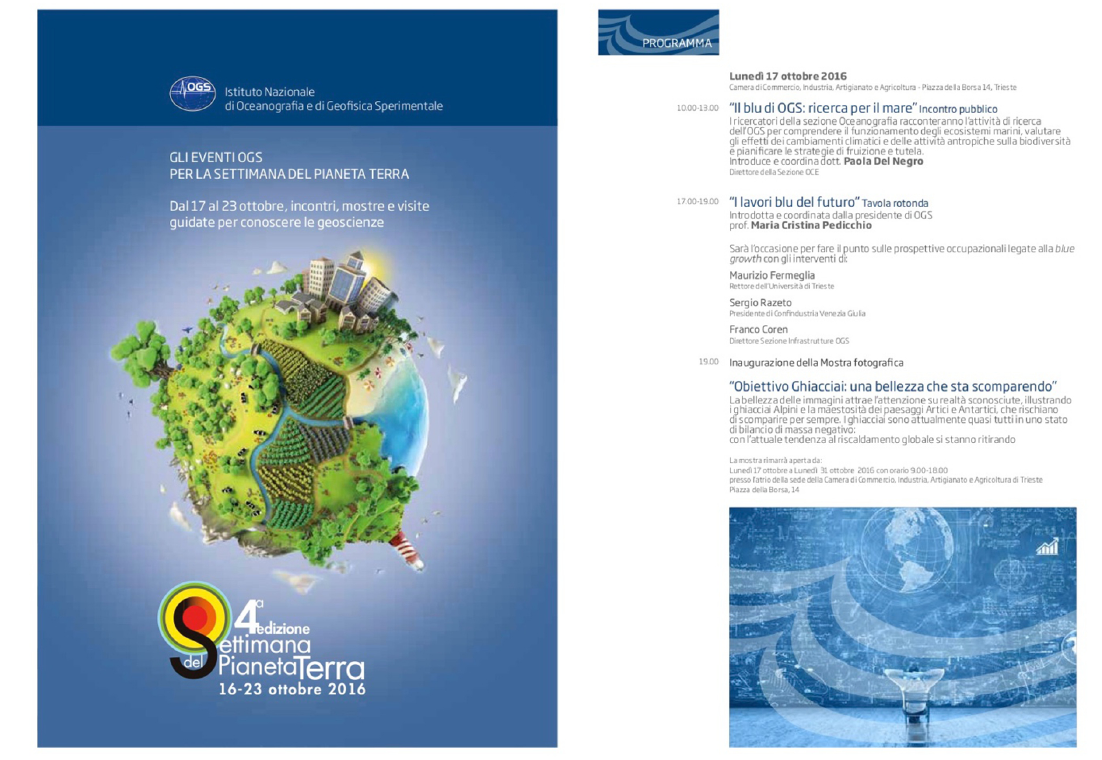
Figure 1. A sample of the flyer that reported some of the events organized by the OGS during the Settimana del Pianeta Terra (Planet Earth Week, https://www.settimanaterra.org, last access: 12 October 2016). The opening of our exhibition titled “Obiettivo Ghiacciai: una bellezza che sta scomparendo” took place on 17 October